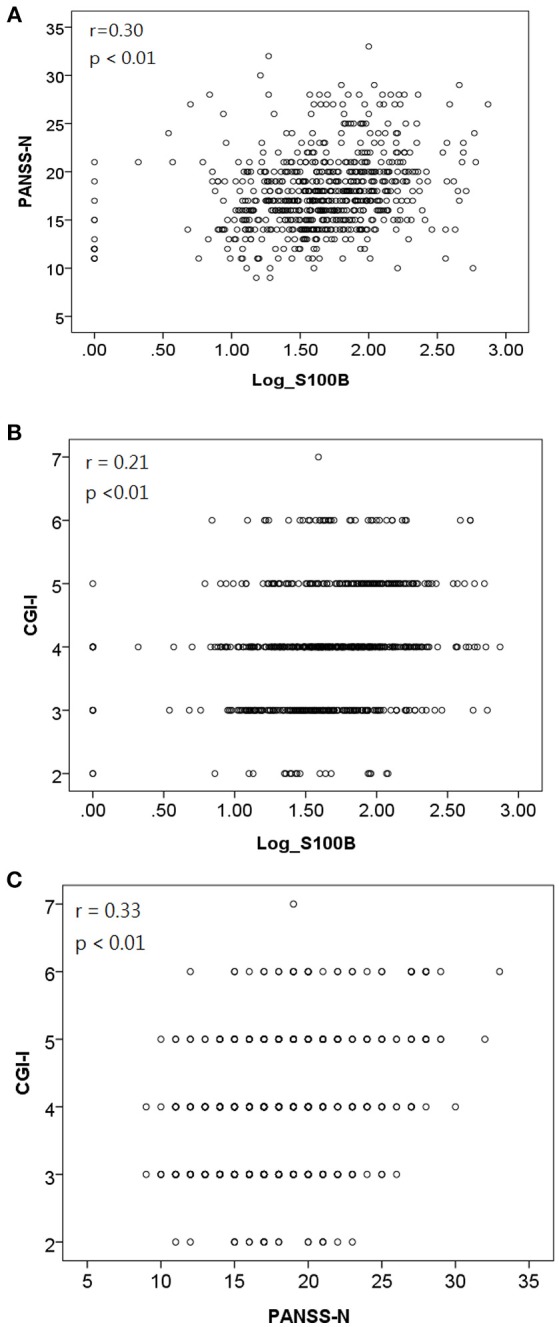
Pearson correlation coefficients indicated a positive correlation between (A) log level of S100B and PANSS-N [r = 0.30, p < 0.01]; (B) log level of S100B and CGI-I [r = 0.21, p < 0.01]; (C) PANSS-N and CGI-I [r = 0.33, p < 0.01].